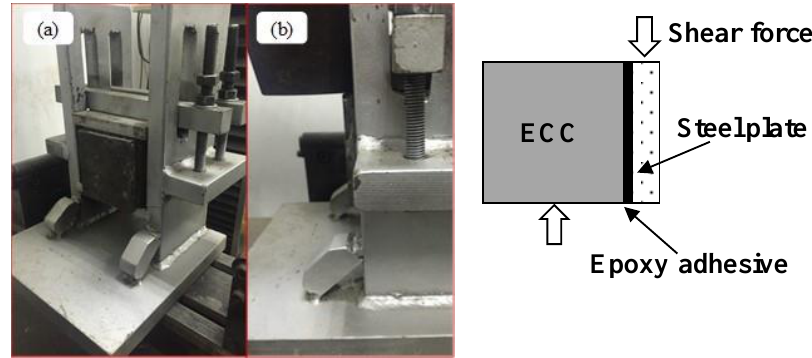
Figure 4. Single shear test: (a) Front view, (b) Side view.